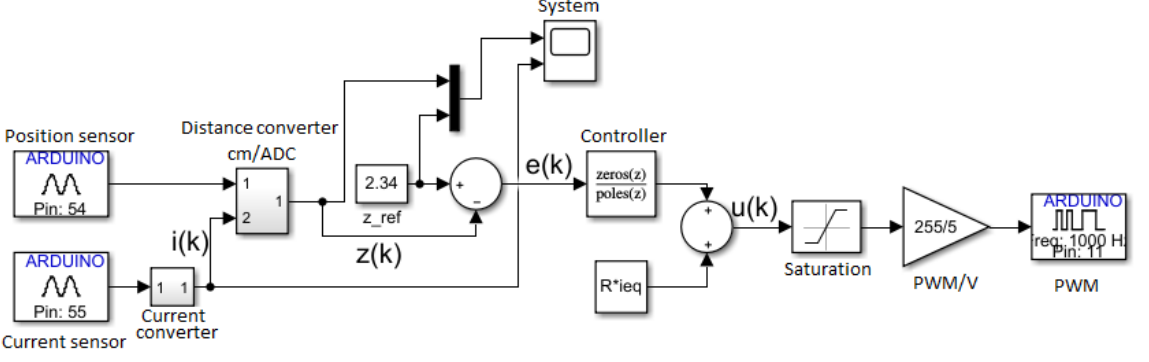
Figure 9. Simulink diagram used to test the classical